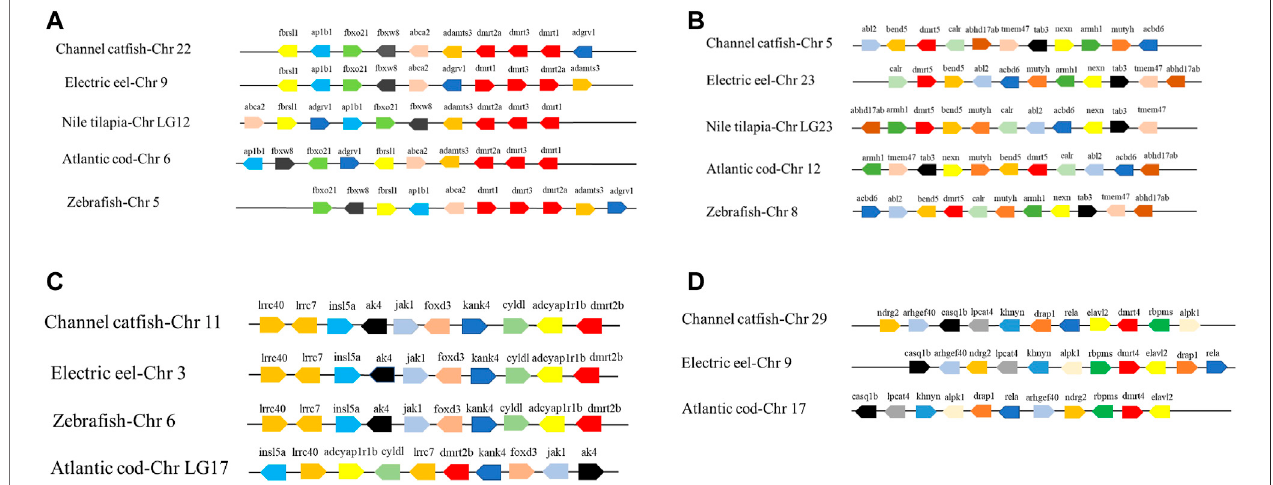
FIGURE 4 | Synteny analysis of Dmrt1 , Dmrt2 , Dmrt3 (A) , Dmrt5 (B) , Dmrt2b (C) , Dmrt4 (D) and their adjacent genes in electric eel, Nile tilapia, Atlantic cod, and zebra fi sh. Direction of the arrows indicates gene orientation.